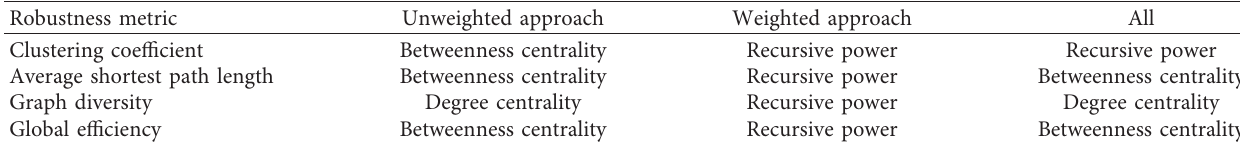
Table 3: Comparison of robustness metrics in unweighted and weighted